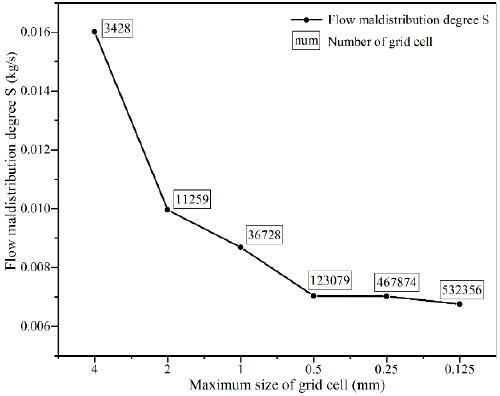
Figure 4. Results of the grid independence test.